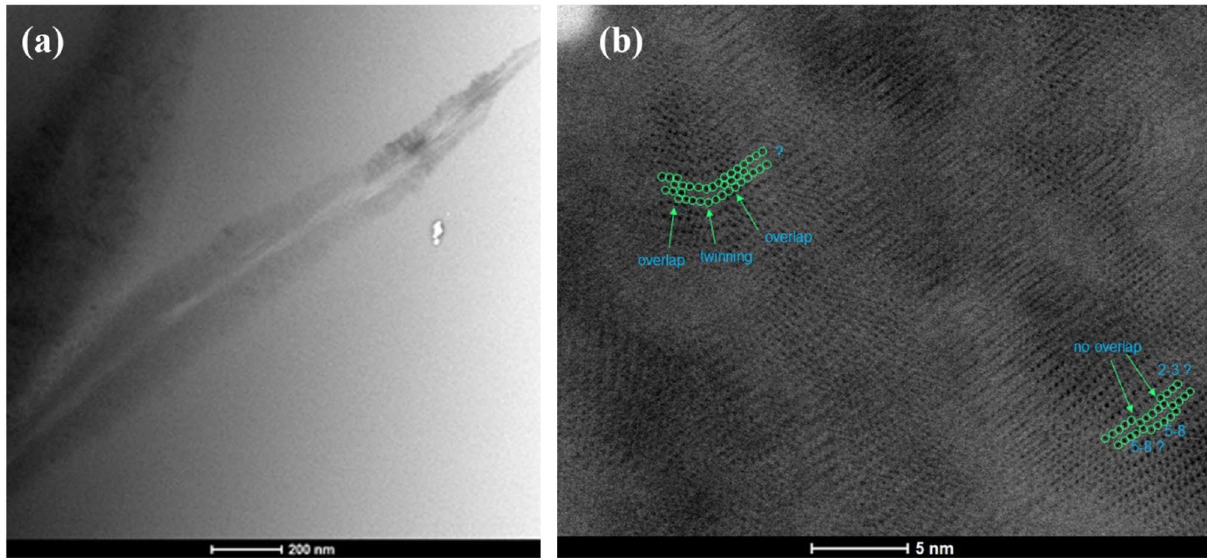
Figure 9. Bright-field STEM images of the 1–2 sample at different magnifications (see scale bar lower middle of each panel). The complete needle-like crystal is shown in ( a ). The zoomed crystal with suggested stoichiometries are highlighted in ( b ). Question marks indicate uncertainty about the stoichiometry because the it is not clear if rows of atoms at the nanocrystal edge terminate fully capturing the whole row for a given